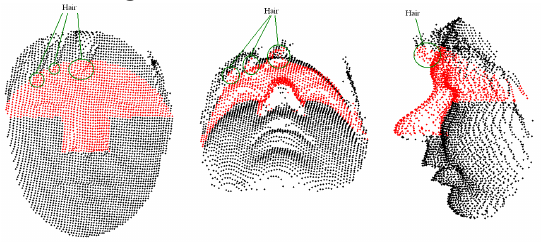
Fig. 14. The hair could damage the symmetry of the shape in expression-invariant region. The hair noise also could affect the results of ICP-based alignment.